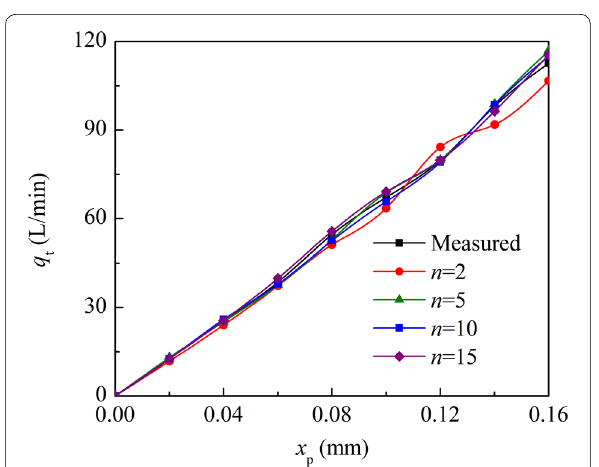
Figure 7 Comparisons between the inferred data and the measured data in case 1